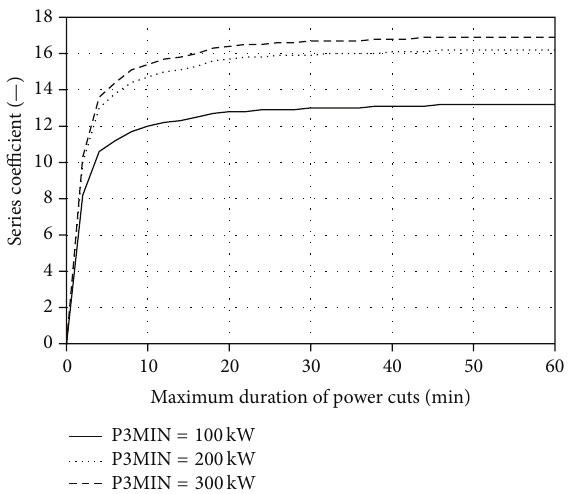
Figure 10: Family of characteristics 𝑘 1 = 𝑓(𝑇 ) for Enercon E53 E53 turbine and the system power of 𝑃 3 MAX between 1 June 2010 and 31 Aug.